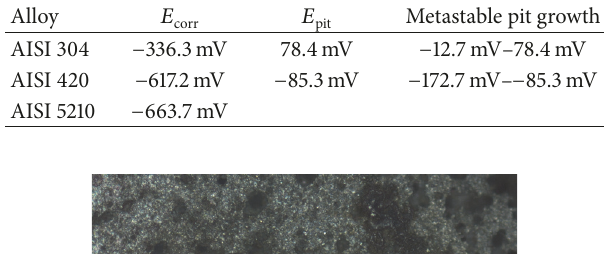
Figure 8: Microscope recording of AISI 420 after polarization scan in phosphate buffer containing 3.5 wt.%.